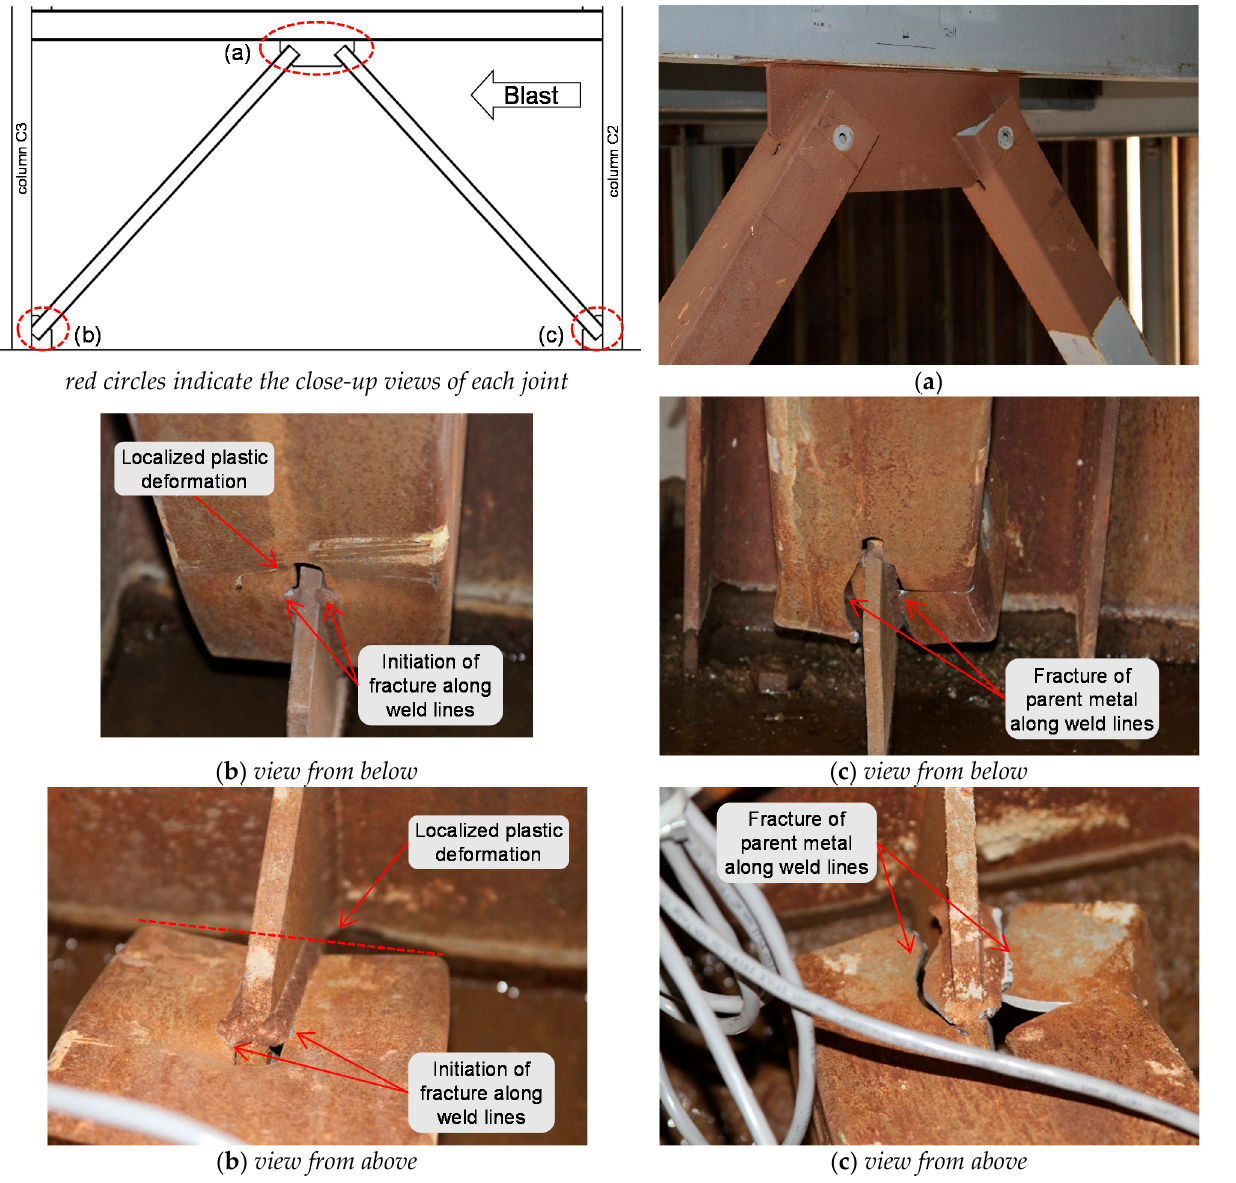
Figure 18. Test 2—First floor brace connections at column line C: ( a ) Top gusset joints; ( b ) Base gusset joint with column C3 (see Figure 19 for a magnified view); ( c ) Base gusset joint with column C2.